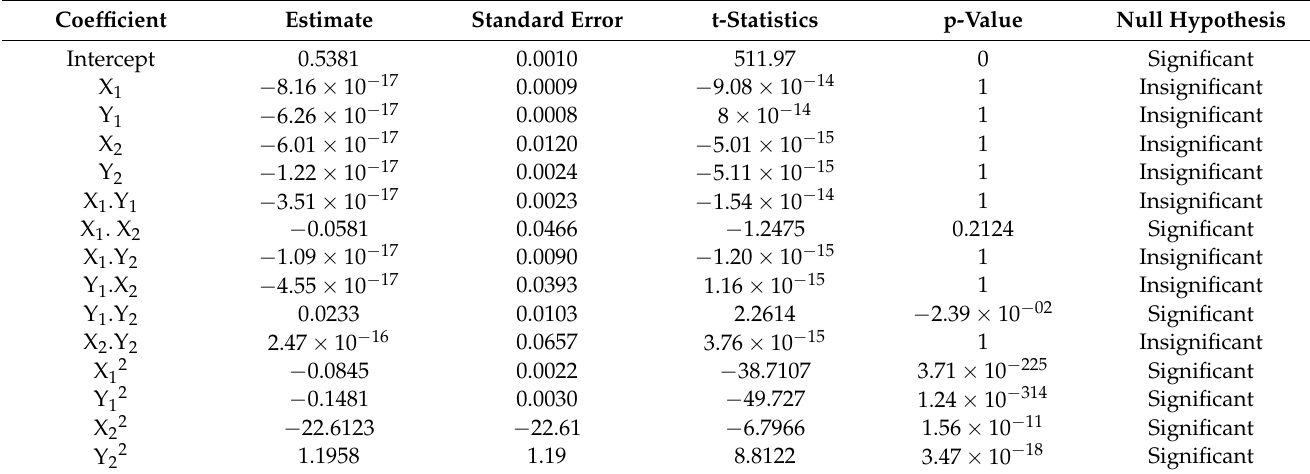
Figure 4. Topofatmosphere (TOA) reflectance vs. spherical coordinate ( a ) solar and ( b ) view angles for EO-1 SWIR1 band before and ( c ) solar and ( d ) view angles after angular conversion from spherical to cartesian coordinate. Table 3. Bidirectional Reflectance Distribution Function (BRDF) coefficients